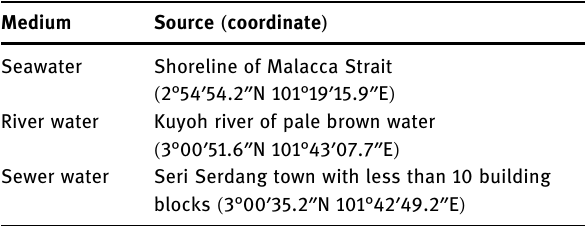
Table 3: Origin sources of seawater, river water, and sewer water Medium Source ( coordinate ) Seawater